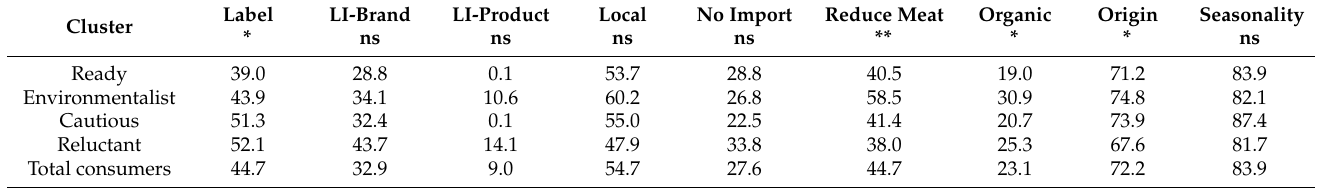
Table 6. Contingency tables reporting the percentage of individual sustainable food choices for each consumer cluster. Label Cluster * Environmentalist 52.1